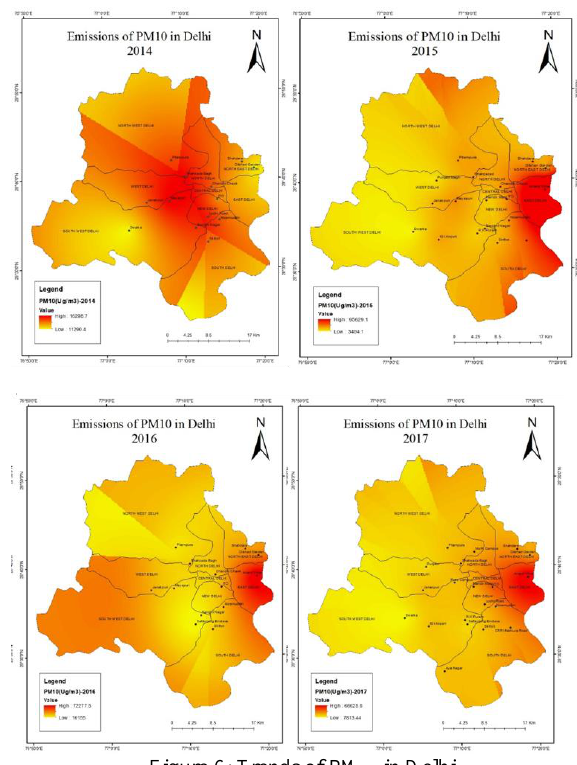
Figure 6: Trends of PM 10 in Delhi So, Aerosols Parameters were used to understand various events in order to ascertain the reasons of high levels of pollution in Delhi. These Parameters are Aerosols Optical Depth (AOD), Angstrom Exponent (AE) and Single Scattering Albedo (SSA). AOD is extinction of sunlight by dust and haze. More the depth means more the hazy conditions, hence pollution in atmosphere. AE is a qualitative indicator about the turbidity of the atmosphere. High AE indicates fine particles and low for coarse particles. SSA is the ratio of scattering efficiency. If this efficiency increases with increasing wavelengths, it indicates the source of pollution coming from Dust storms, otherwise it is sourced to urban-industrial aerosols or biomass burning. The highlighted red circles (Figure 7) indicate the rice-residue burning months and which shows direct relation with high AOD in Delhi. done to validate the multiple weather events that occurred in Delhi causing high level of